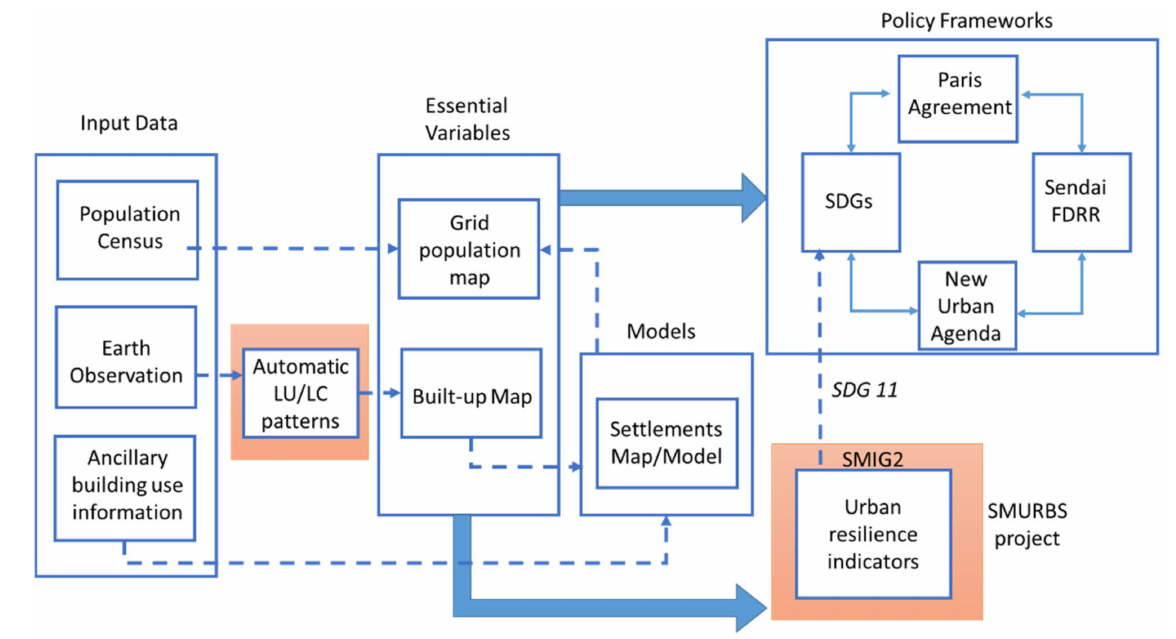
Figure 2. Conceptual model of SMIG2 solution in support of the relevant policy